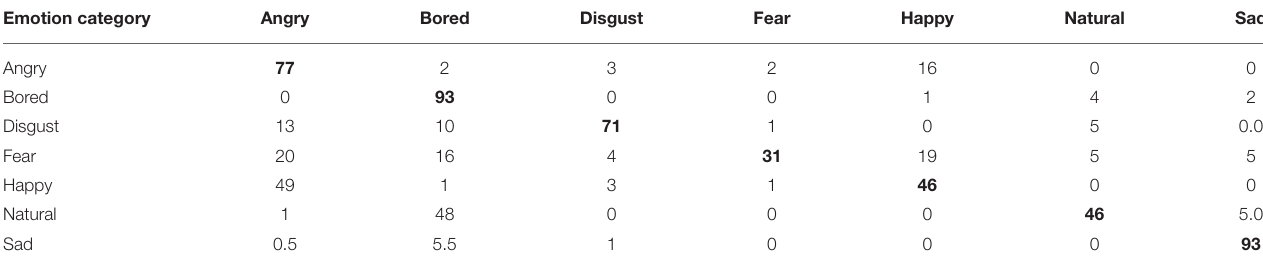
The bold values represent the recognition rate of the adopted method. TABLE 5 | Recognition rate of this method in Emo-DB.